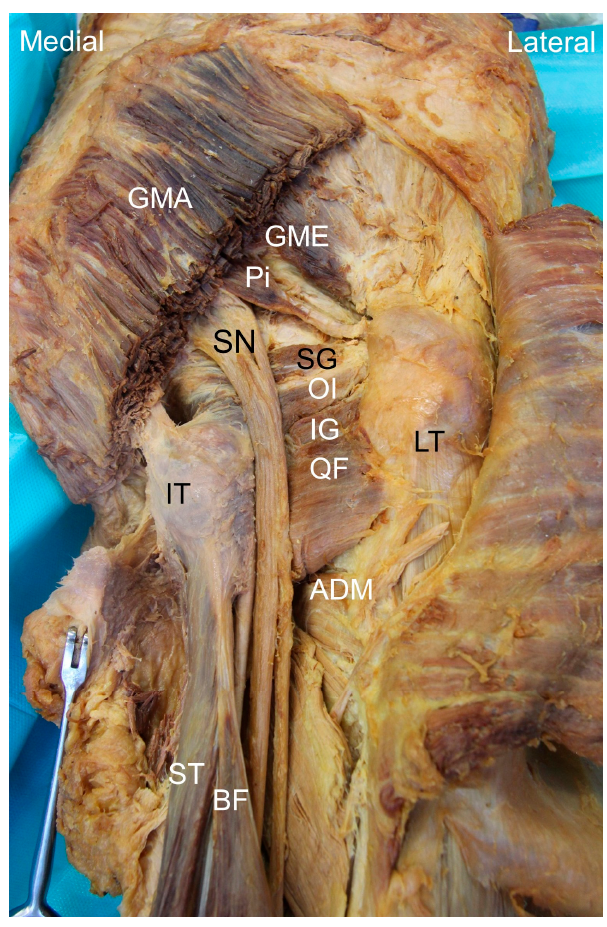
Figure 1. Cadaveric image of the posterior hip region, focusing on the ischiofemoral space. GMA: gluteus maximus muscle; GME: gluteus medius muscle; Pi: piriformis muscle; SG: superior gemellus muscle; OI: obturator internus muscle; IG: inferior gemellus muscle; QF: quadratus femoris muscle; LT: lesser trochanter; IT: ischial tuberosity; ST: semitendinosus; BF: biceps femoris; ADM: adductor magnus muscle; SN: sciatic